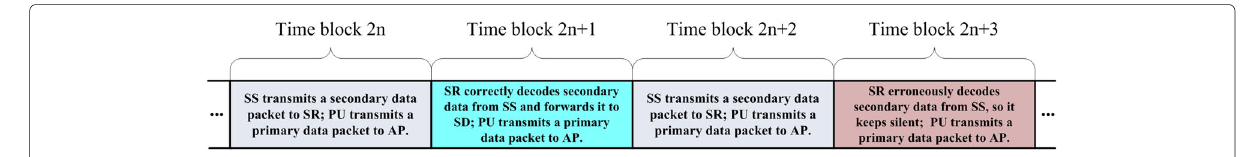
Fig. 2 Transmission process of the cognitive DF relaying with n =